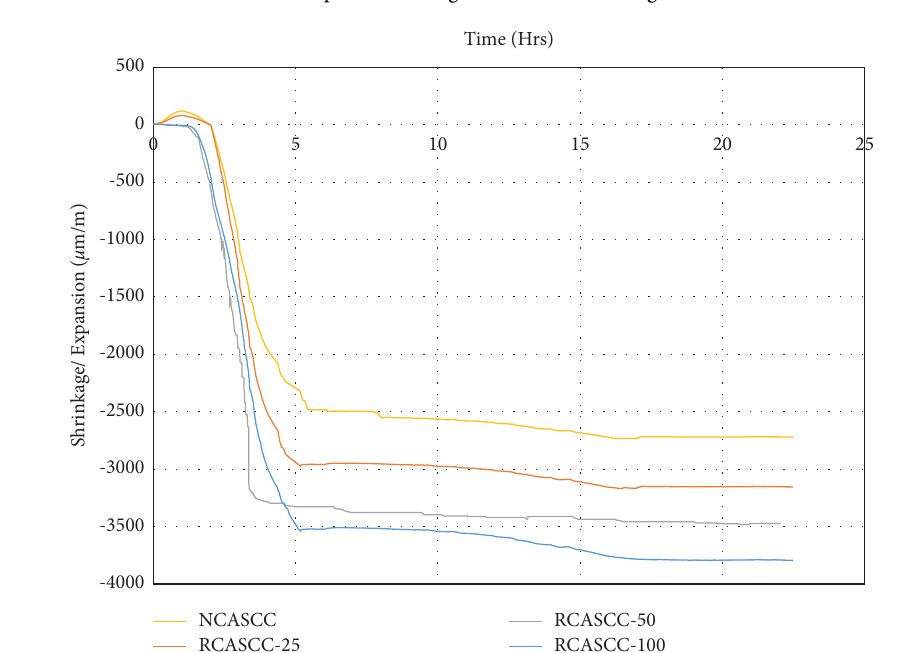
Figure 7: Shrinkage response against time.